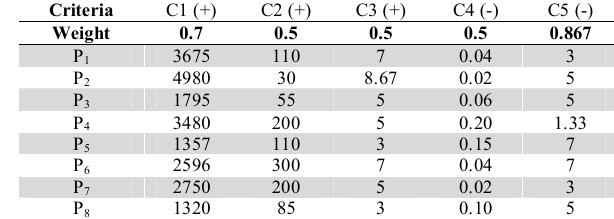
Initial decision matrix Defuzzified decision matrix along with weight matrix Criteria